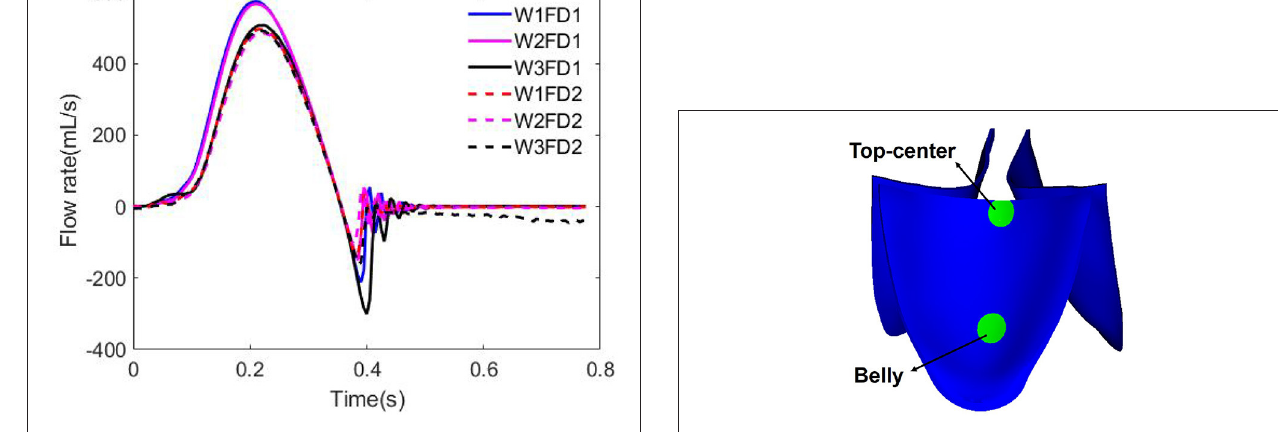
FIGURE 8 | Flow rate comparison for the six cases. FIGURE 10 | Two labeled regions of the aortic valve (AV) leaflet.